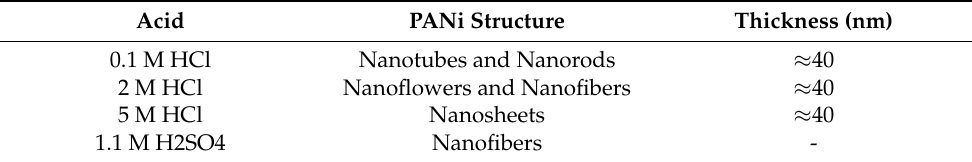
Table 3. Comparison of PANi structure produced from different molarities of acid [79].